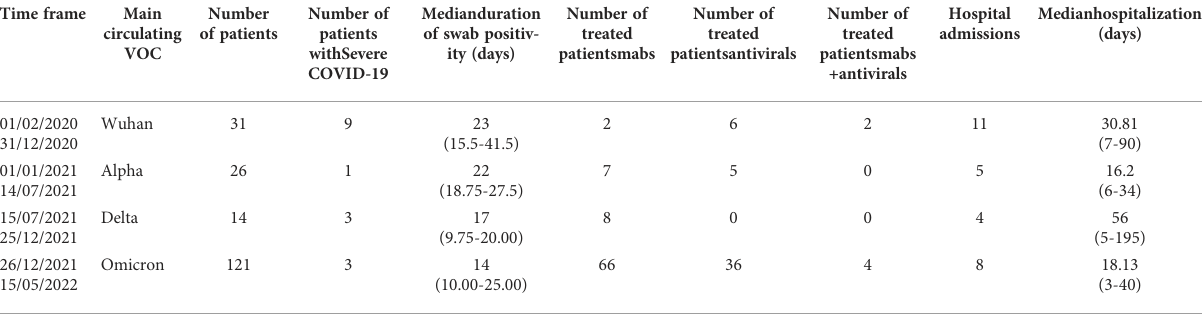
TABLE 2 Summary of data of SARS-CoV-2 infected IEI patients in relation to main circulating strains, administered treatment, hospital admission and duration of positive swab. Time